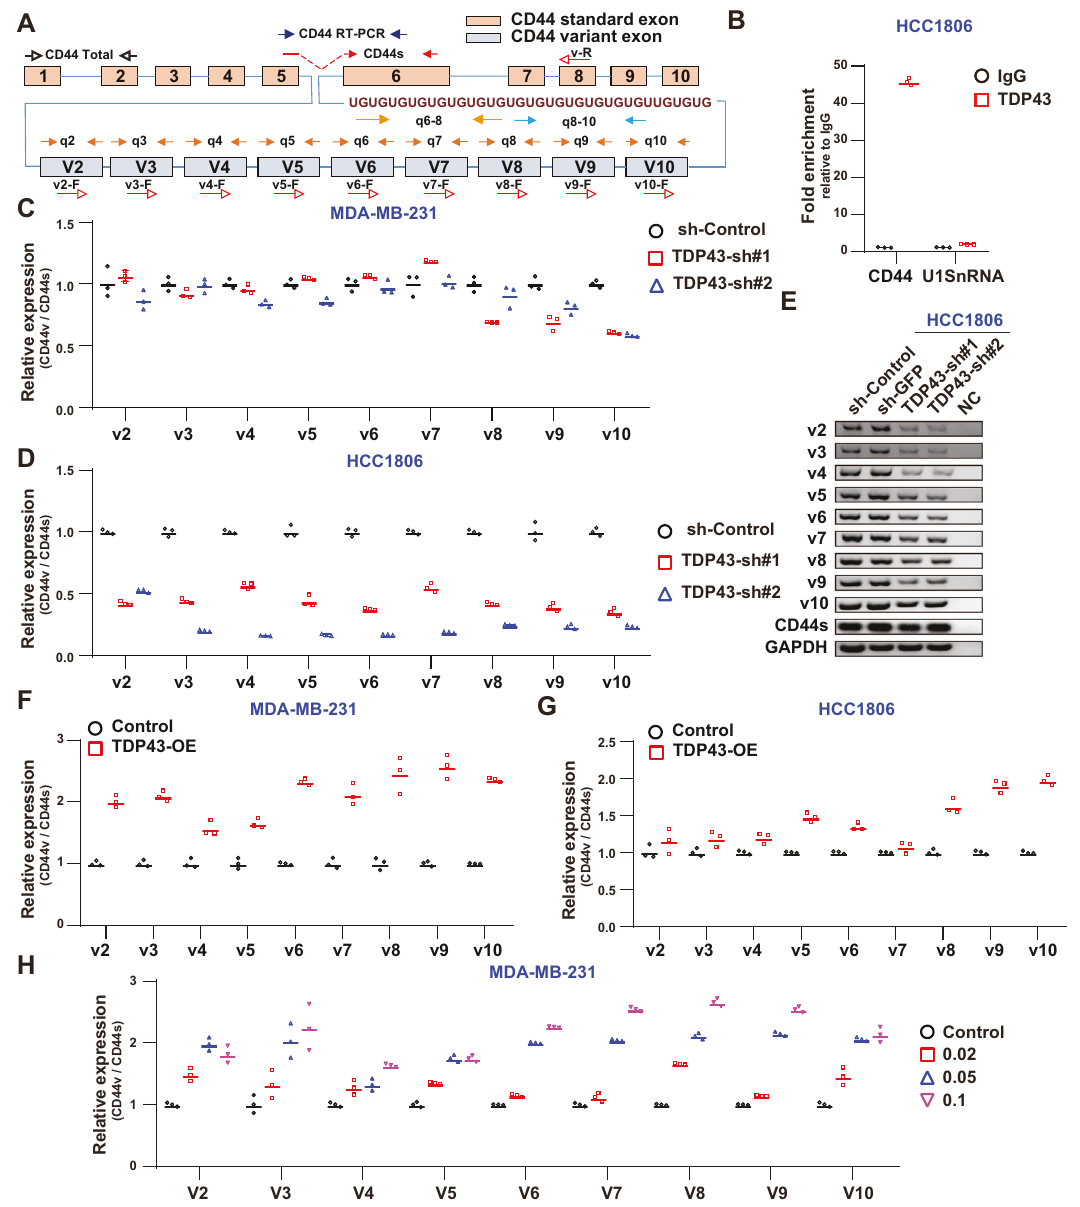
Fig. 2 TDP43 regulates AS of CD44. A Schematic of CD44 pre-mRNA structure and TDP43-binding motif. Arrows indicate primers for qPCR (q) and RT-PCR (vx-F and v-R). B Binding of CD44 mRNA to TDP43 proteins detected by RIPA in HCC1806 cells. C , D qPCR analysis of changes in CD44v/s following TDP43 KD. E Semi-quantitative RT-PCR of CD44 isoforms upon TDP43 KD. The primer pairs (vx-F and v-R) are applied for CD44v ampli fi cation. e.g., v2 band is ampli fi ed using v2-F and v-R primers. F , G qPCR analysis of CD44v/s ratio following TDP43 OE. H qPCR analysis of CD44v/s changes at various TDP43 concentrations by doxycycline induction ( μ g/ml). Data are means ± SD.